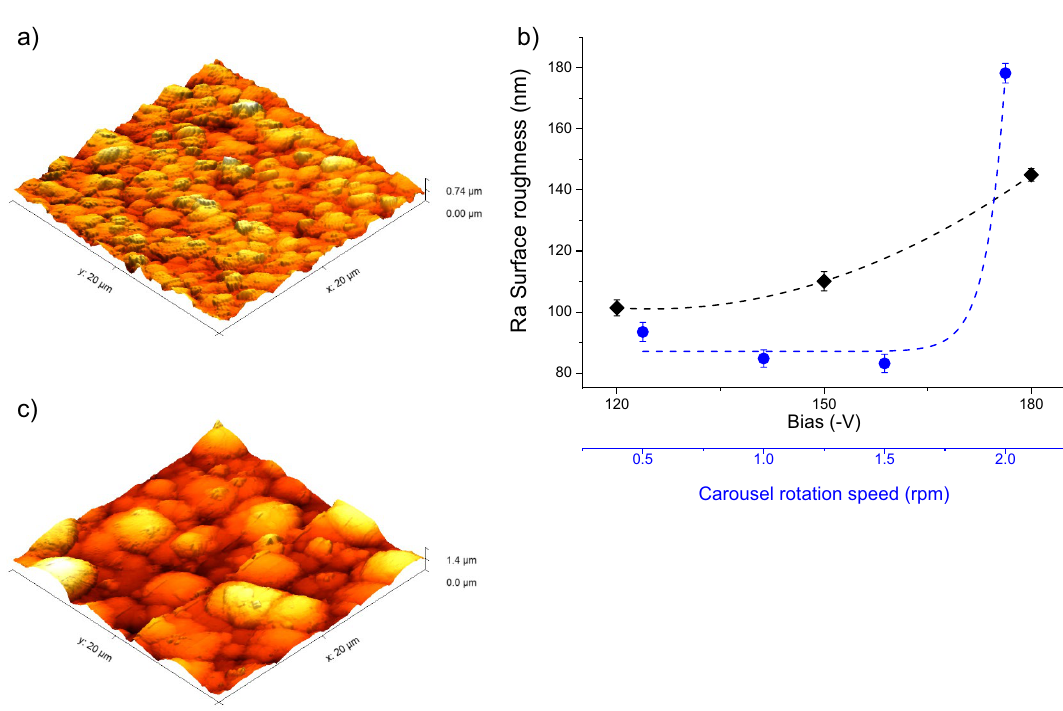
Figure 4. ( a ) 3D AFM surface map obtained from the coating manufactured at 1 rpm and − 150 V, ( b ) effect of bias and carousel rotational speed on the surface roughness and ( c ) 3D AFM surface map obtained from the coating manufactured at 2.0 rpm and − 150